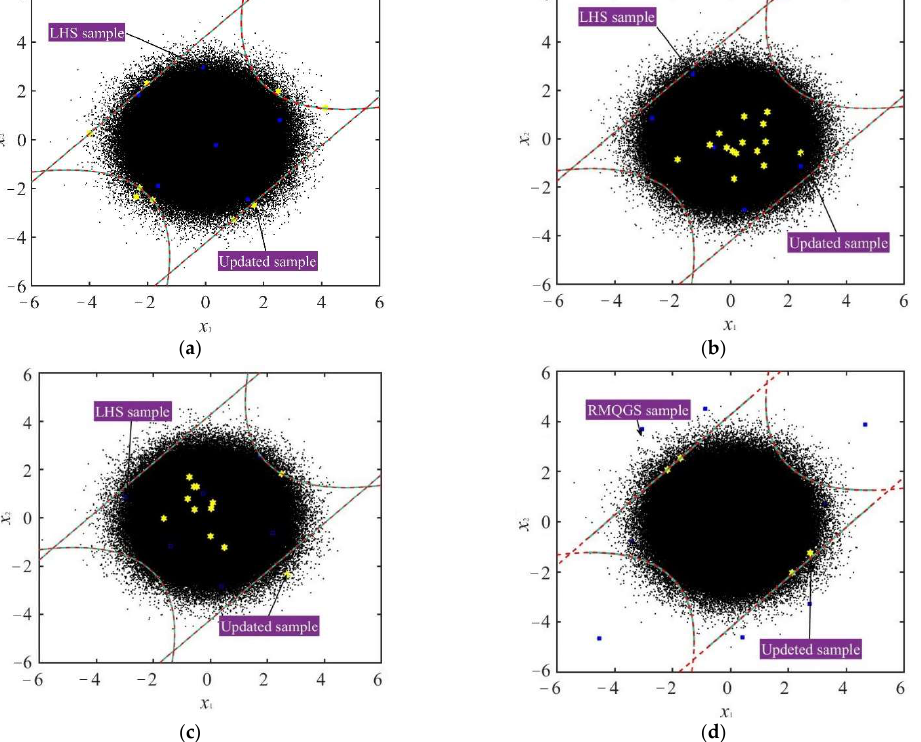
Figure 4. MRGP models and its samples distribution for the series system. ( a ) MRGP + U; ( b ) MRGP + H; ( c ) MRGP + EFF; ( d ) Proposed method. Figure 4 depicts the fitting accuracy of the MRGP model with different active learn- Table 1. Results of example 4.2 with different ing functions. In Figure 4, the black dots are MC simulation sample points; the blue dots are initial samples obtained by LHS or RMQGS; the green lines are the fitting curve of the MRGP model; the red lines are the true limit state surface; the yellow dots are updated